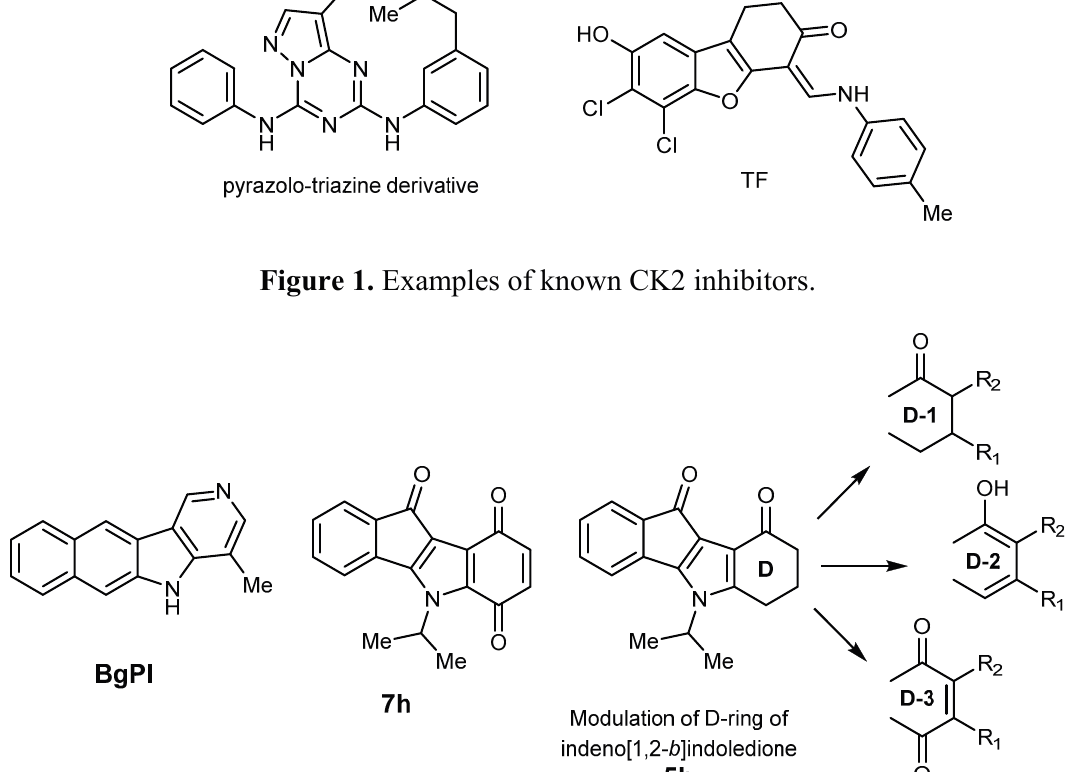
Figure 2. Scaffolds for designing CK2 inhibitors and D-ring modulation on indeno[1,2- b